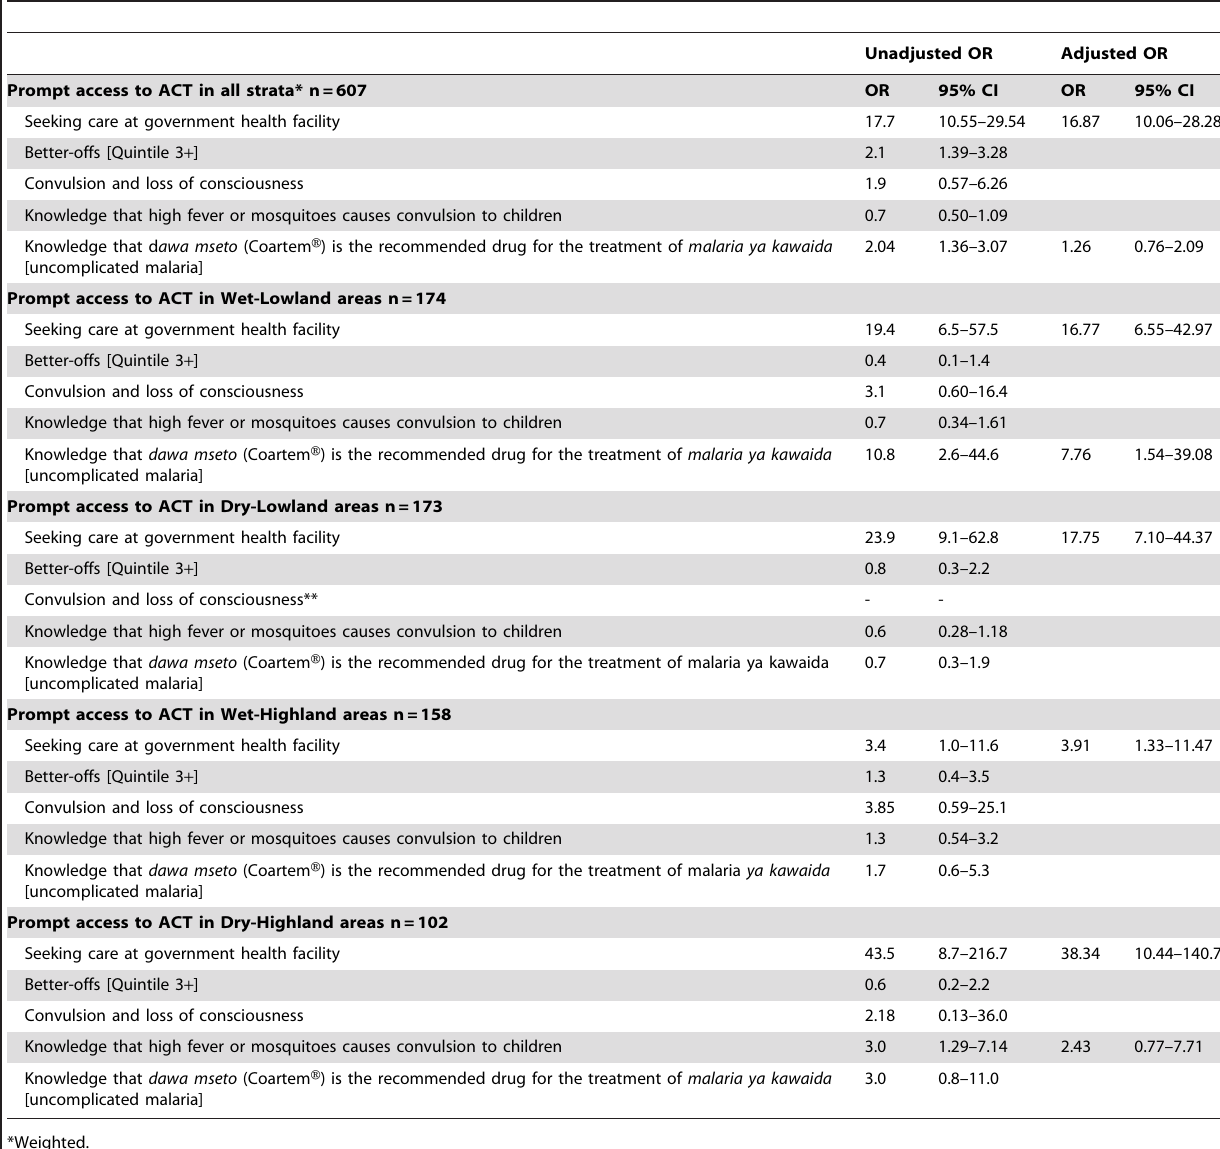
Table 2. Determinants of accessing appropriate antimalarials (ACT) on the same or next day (promptly) for children under five reported to have fever by geographical-climatic